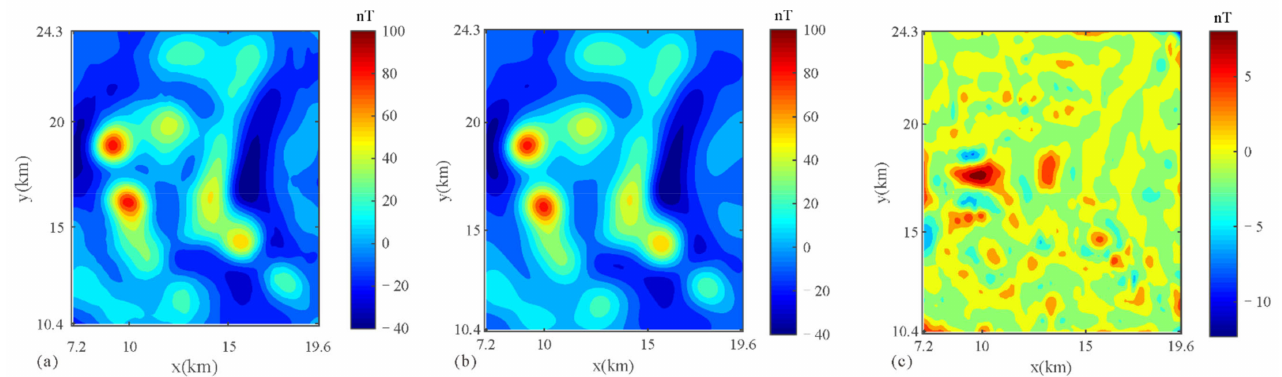
Figure 11. High-value area of magnetite-caused RTP anomaly maps in Litun Pluton subregion: ( a ) observed data; ( b ) predicted data from the inversion model; ( c ) difference between the observed and predicted